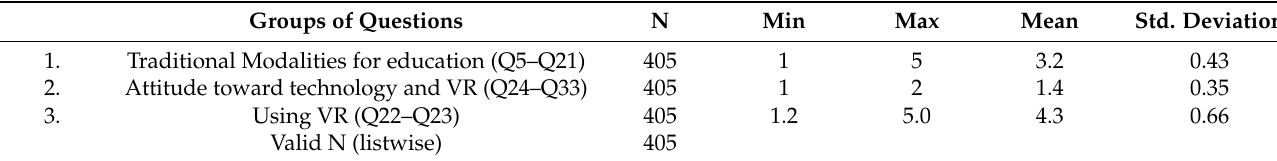
Table 6. Standard deviation checking of descriptive